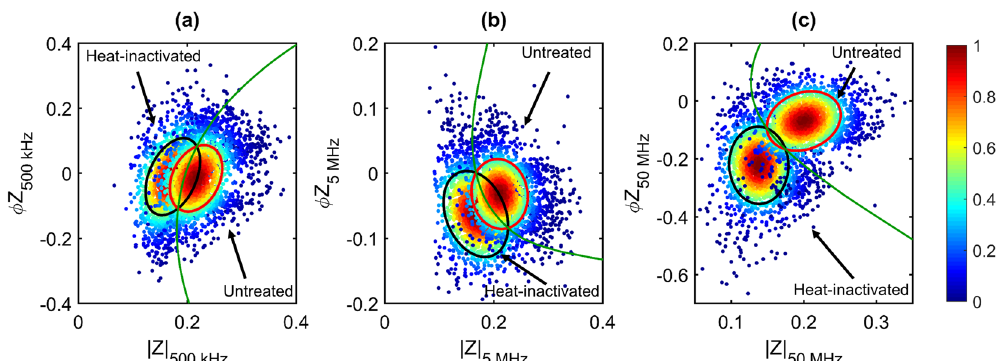
Figure 7. Impedance scatter plot for C. parvum in 5x PBS. Low, intermediate and high frequency impedance data for untreated and heat-inactivated C. parvum are plotted together at ( a ) 500 kHz, ( b ) 5 MHz and ( c ) 50 MHz. Annotated confidence ellipses contain ~50% of untreated or heat-inactivated populations (1,000 events plotted for each population). The green line indicates the equal probability boundary between the two populations. The colour of each data point represents the normalized proximity of the event to the respective population